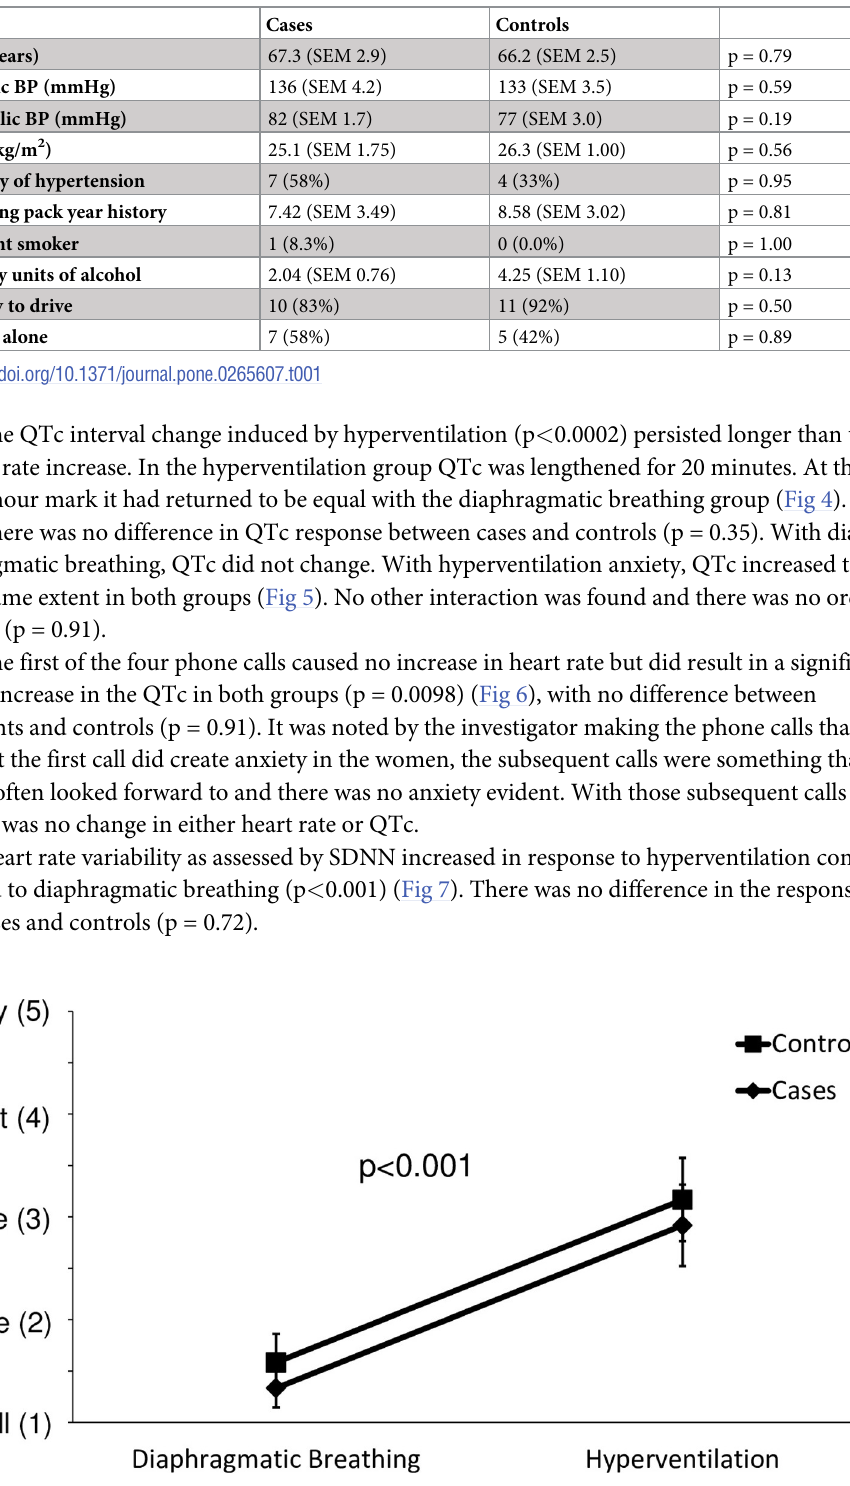
Fig 2. The effects of hyperventilation versus diaphragmatic breathing on subjective anxiety in cases and controls, as measured by a five-point Likert scale.